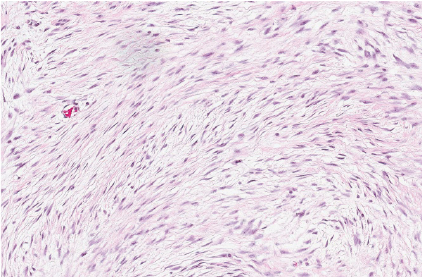
Figure 5: Medium power view ( × 20) is H&E stain of the tumor showing spindle cells (fibroblasts in sweeping fascicles).